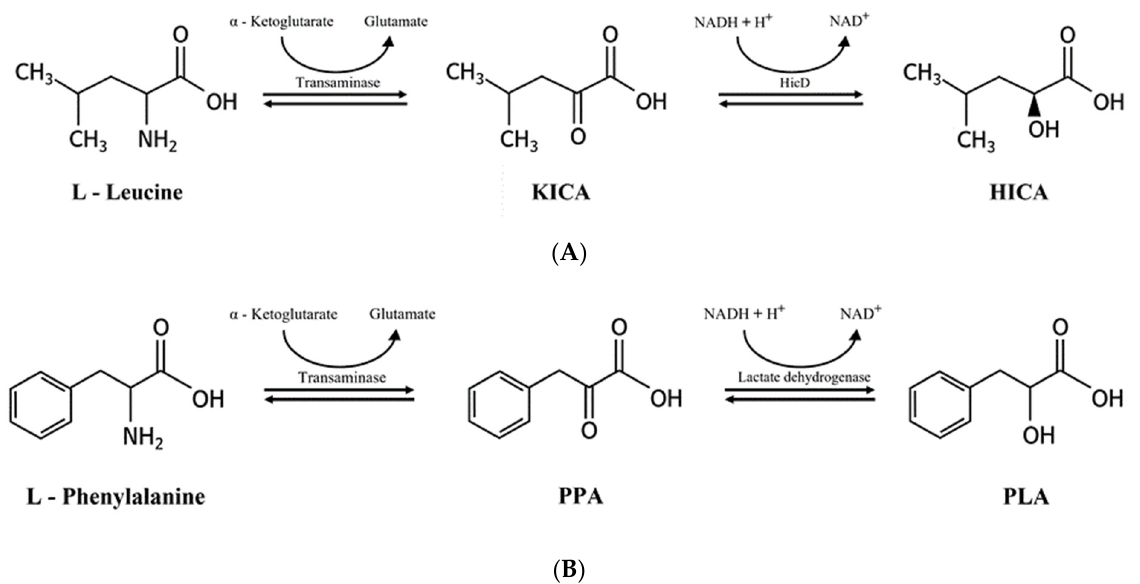
Figure 4. Production of HICA ( A ) and PLA ( B ) from corresponding amino acid precursor, L-leucine and L-phenylalanine, respectively. KICA, 2-ketoisocaproic acid; HICA, 2-hydroxyisocaproic acid; PPA, phenylpyruvic acid; PLA, 3-phenyllactic acid.